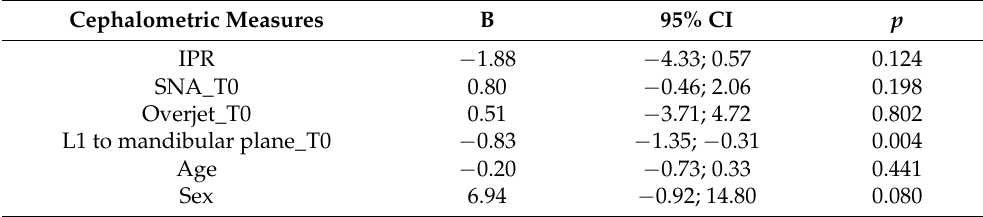
Table 3. Linear regression analysis between amount of IPR, SNA_T0, Overjet_T0, Age, Sex, L1 to mandibular plane_T0 and L1 to mandibular plane_(T1–T0). The significance level was set at p < 0.05. Beta coefficients (B) and 95% confidence interval (95% CI) are